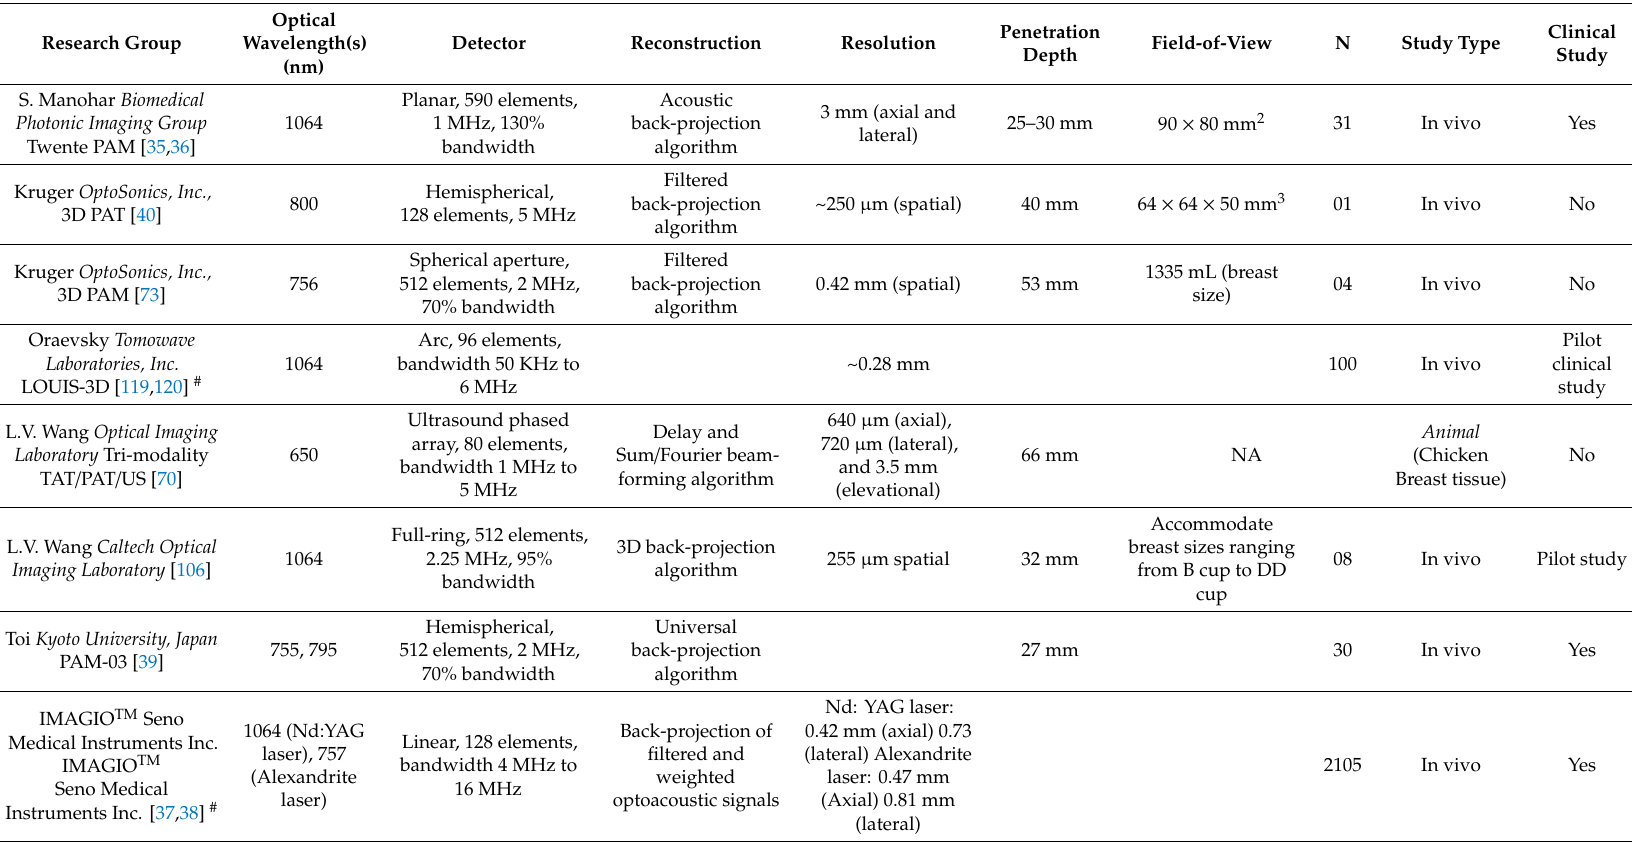
Table 5. Comparative analysis of system configuration of various photoacoustic imaging systems used by di ff erent research groups. Research